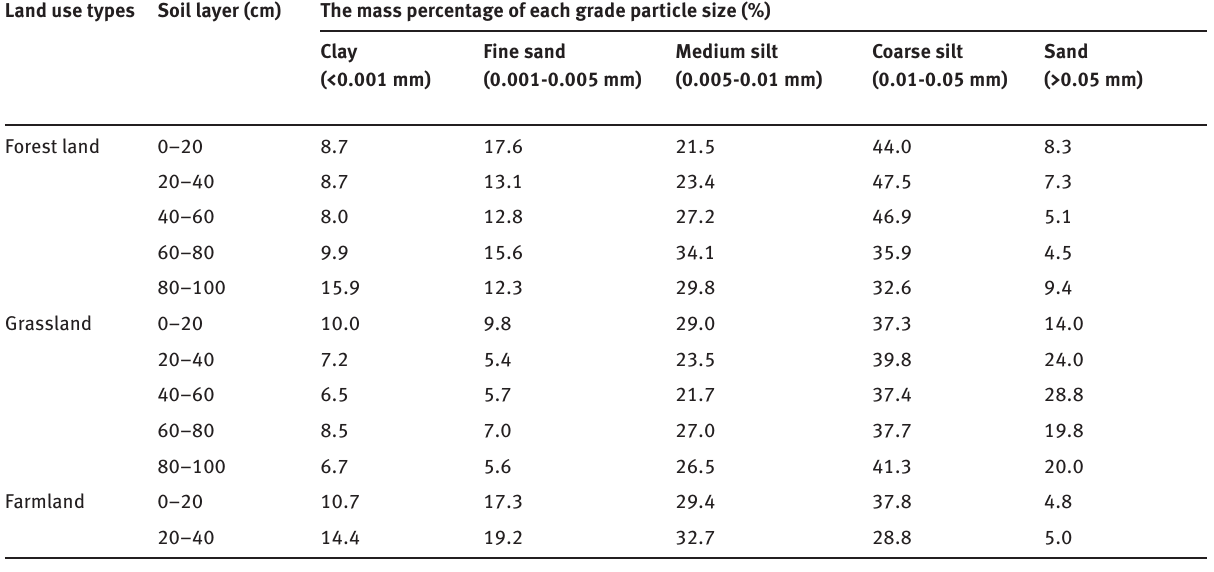
Table 2: Soil mechanical composition by soil depth under the different land use types. Land use types Soil layer (cm)